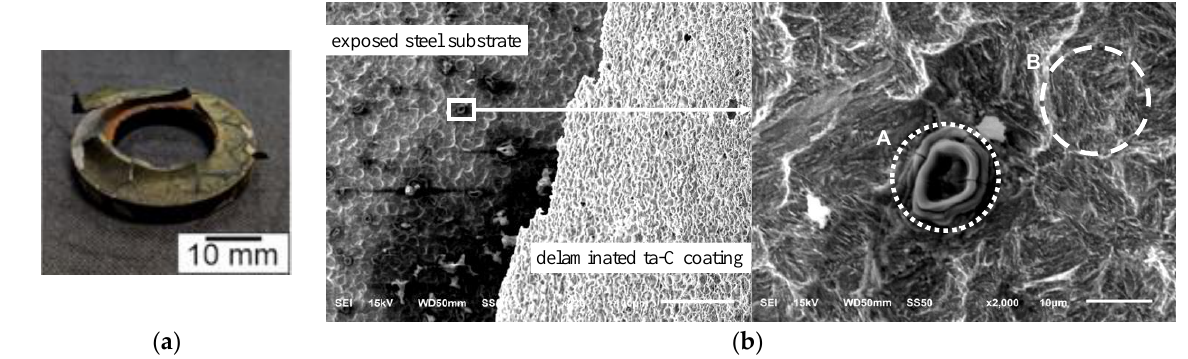
Figure 13. St-noCr-C sample: ( a ) overall appearance; ( b ) SEM images after the exposure to 15% HCl for 3 h. Delamination of ta-C coating exposes corrosion pits on the steel substrate (left). A higher magnification of a corrosion pit is shown on the right.